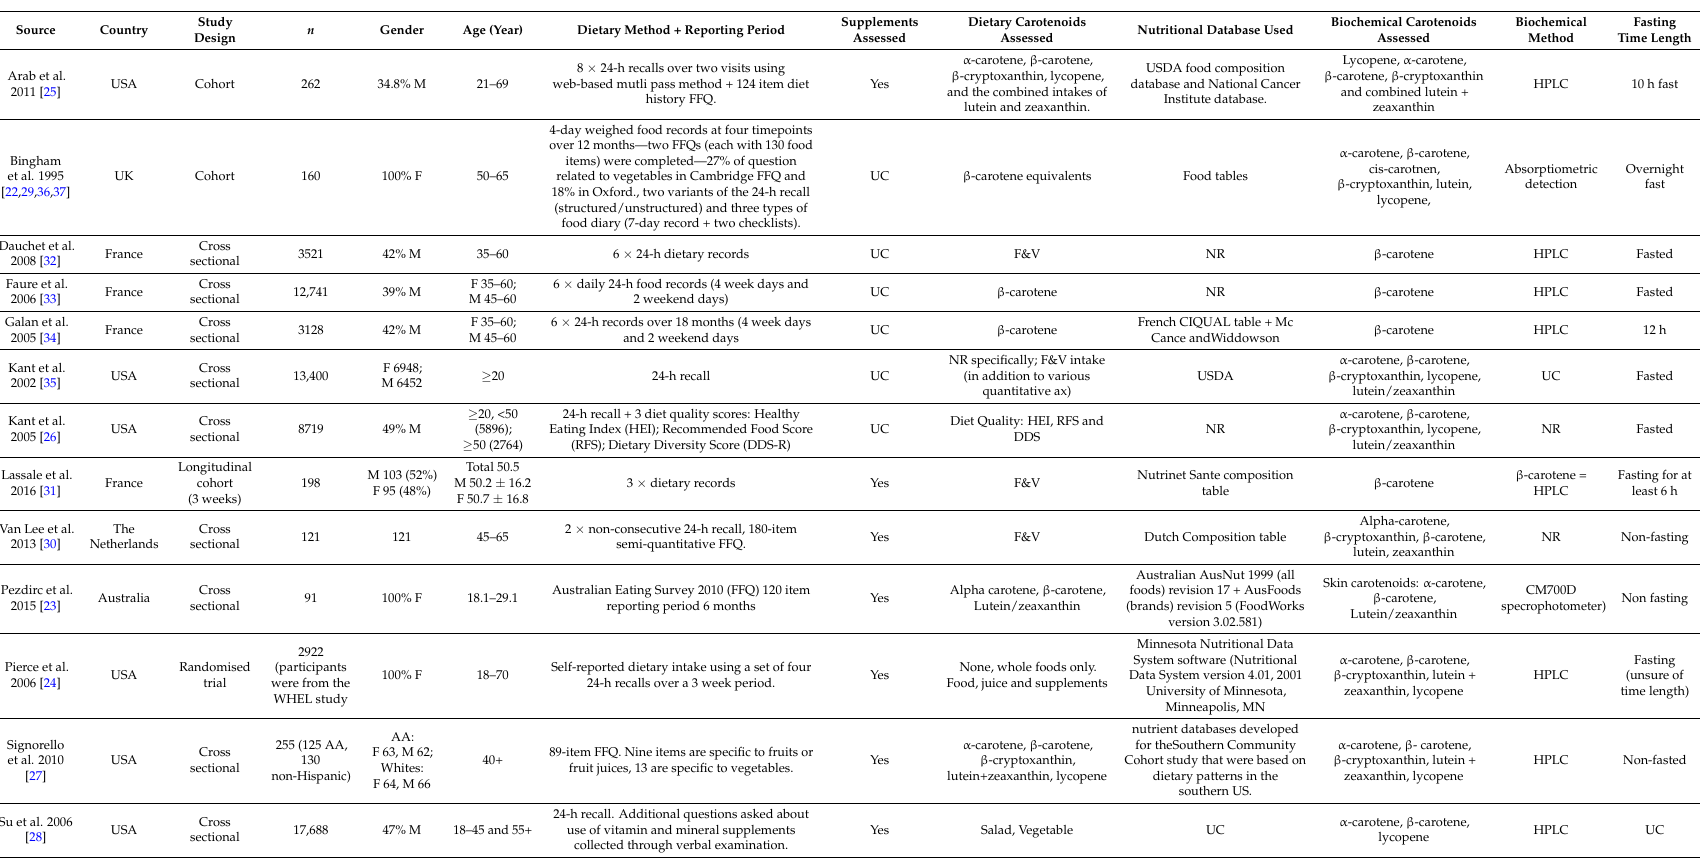
Table 1. Description of included